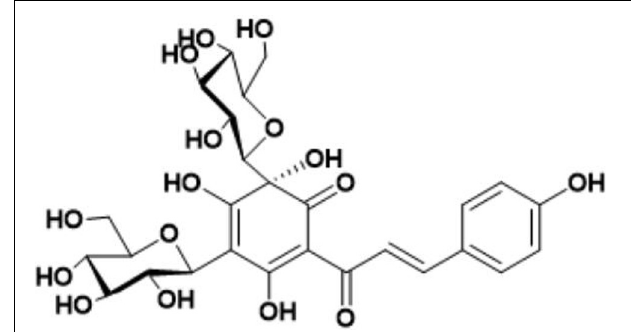
FIGURE 1 | Molecular structure of